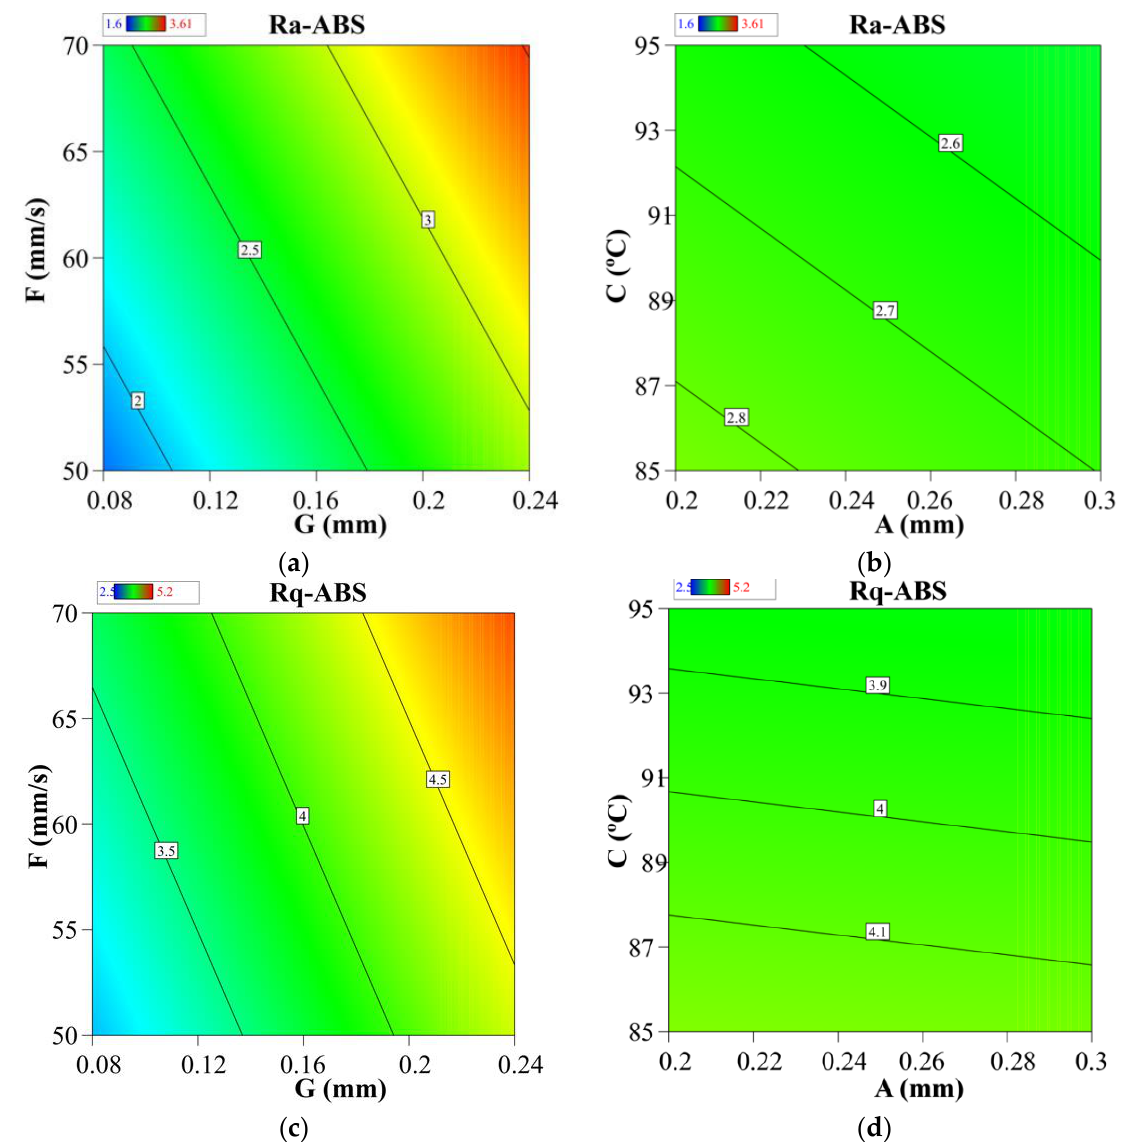
Figure 6. Contour graphs: ( a ) “G” vs. “F” for Ra-ABS, ( b ) “A” vs. “C” for Ra-ABS, ( c ) “G” vs. “F” for Rq-ABS, and ( d ) “A” vs. “C” for Rq -ABS.